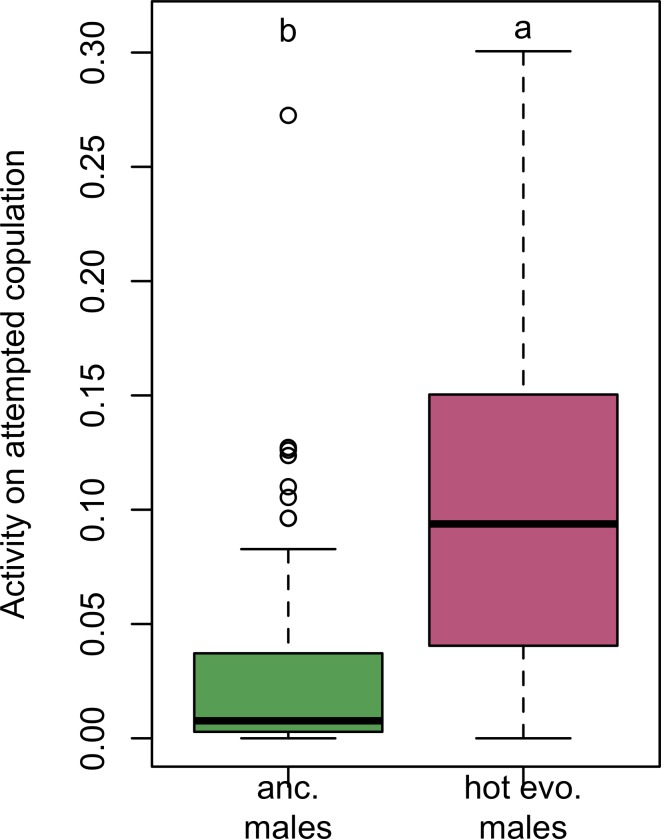
Time male flies attempting to copulate.Evolved males spent significantly more time chasing females (Wilcoxon’s test, W = 1174, p<0.001).